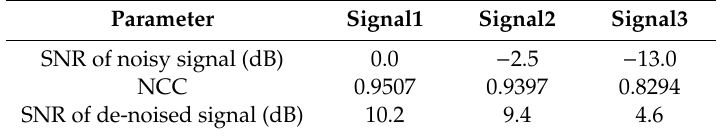
Table 2. Quantitative evaluation results of adaptive wavelet packet for di ff erent levels of noise. Parameter